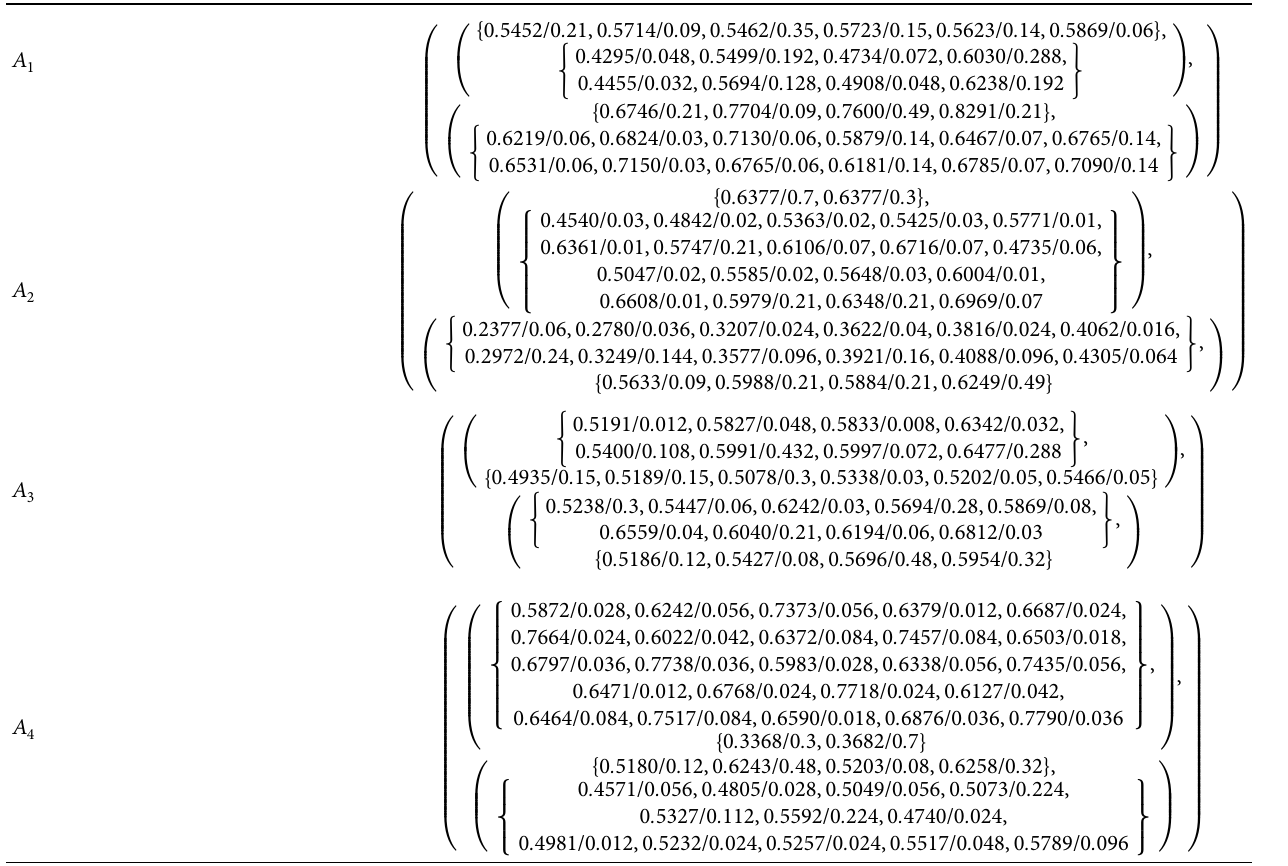
Table 11: Updated aggregated information using q